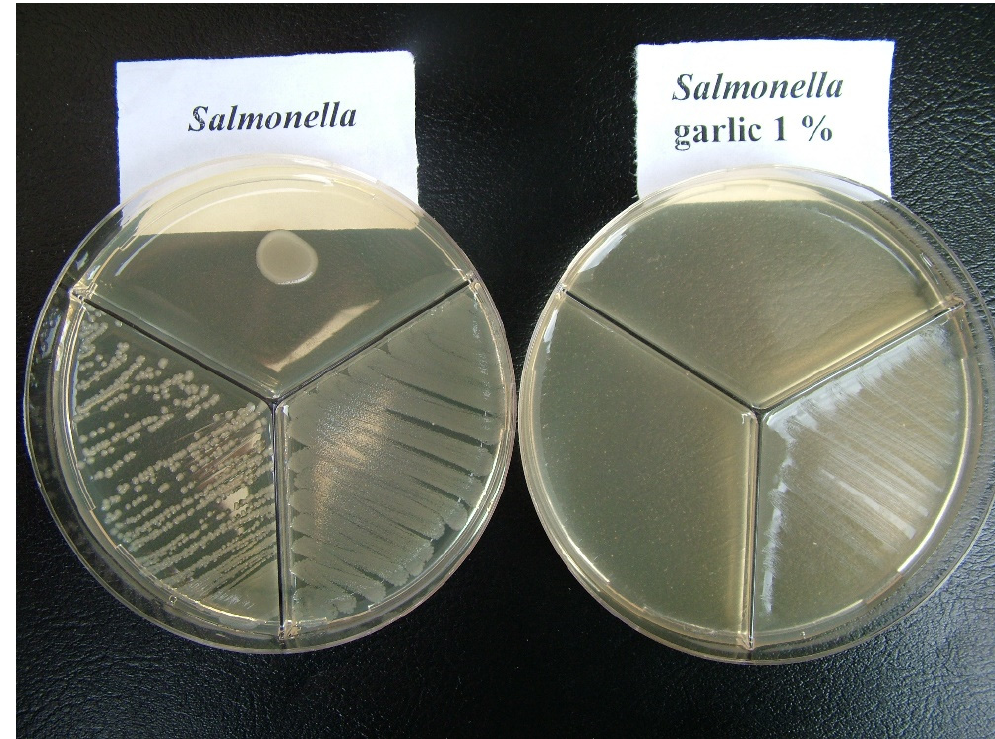
Figure 2. Salmonella . Left side: bacterial growth on the medium without garlic. Right side: total inhibition of growth in presence of 1% garlic.